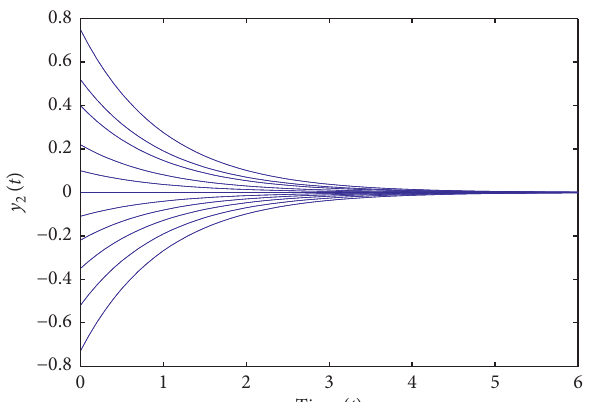
( t ) with θ � ( 1/9 ) , k � 0 . 01 in (38). 2